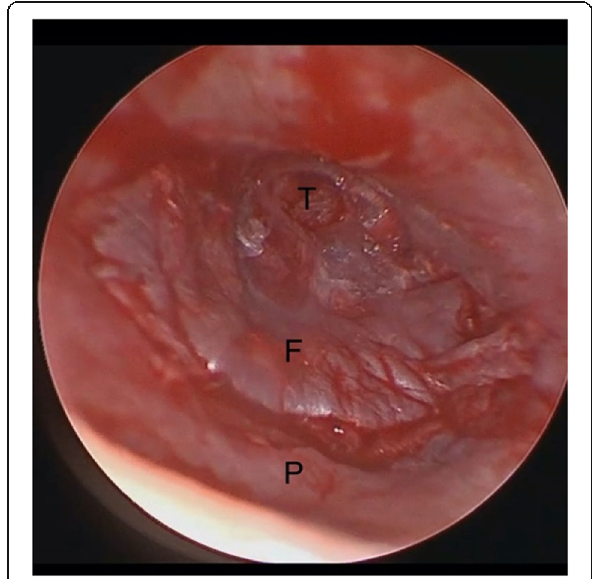
Fig. 5 Final placement of the graft under all edges of the perforation and tympanomeatal flap back. P, posterior meatal wall; F, tympanomeatal flap; T, Tutoplast